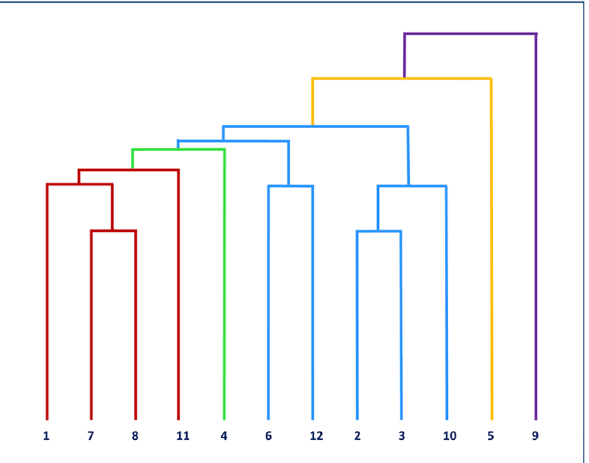
Fig 1. Cluster analysis of transcriptional response to vaccination across all cows included in the RNAseq experiment. Red: non-lactating cows vaccinated prior to calving (BC), blue: early lactating cows vaccinated after calving (AC), green: mid- lactating cow, yellow: non-lactating cow of different genetic background, lavender: non-lactating first calving cow.